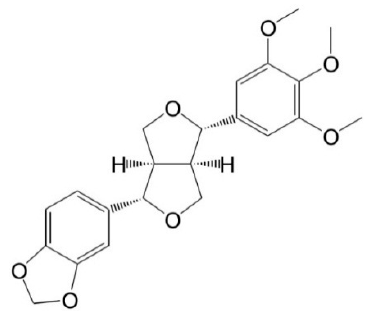
Figure 1. Chemical structure of aschantin.